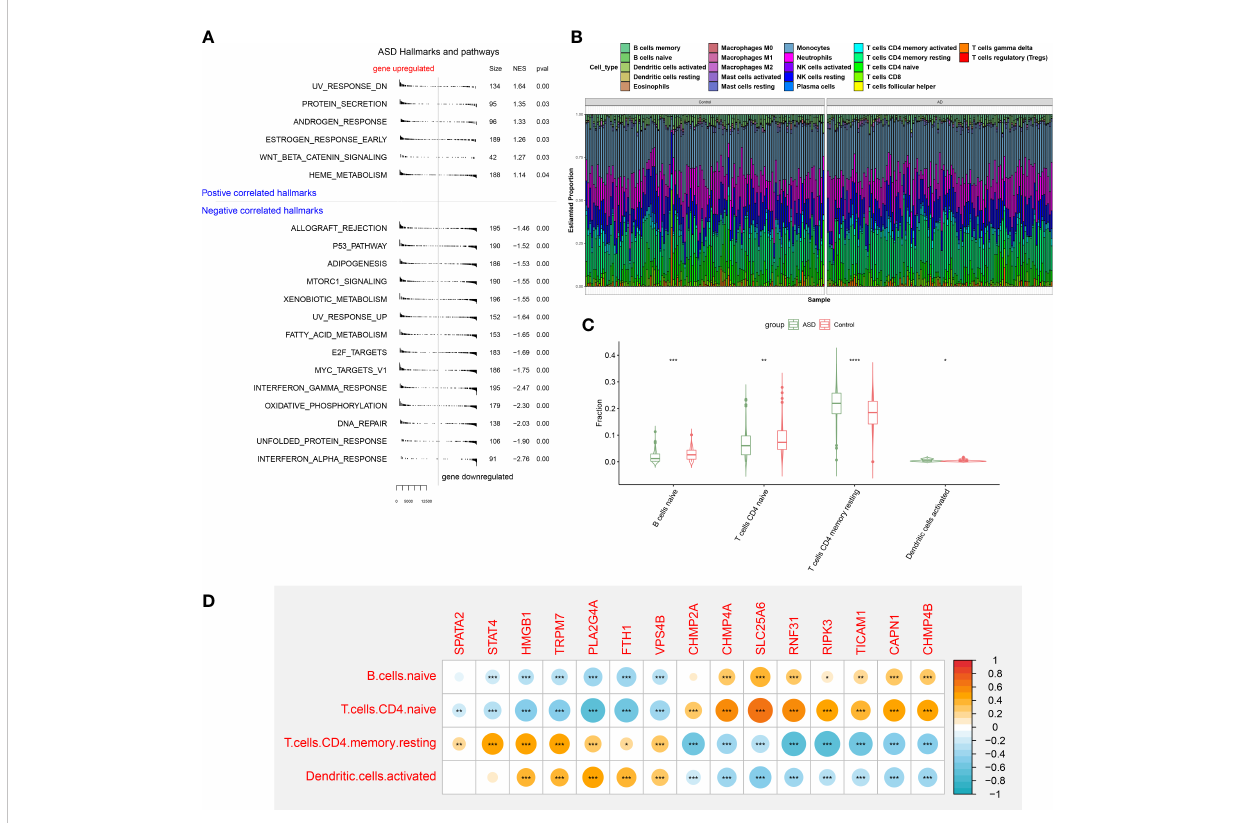
FIGURE 5 GSEA and immune in fi ltration analysis between healthy controls and ASD children. (A) GSEA showing up- or down-regulated KEGG pathways between healthy individuals and ASD children. A p-value less than 0.05 was considered to be statistically signi fi cant. (B) Representative stack chart revealing the relative abundances of 22 in fi ltrated immune cells between healthy individuals and ASD children. (C) Representative box plots revealing the in fi ltration levels of immune cells between healthy individuals and ASD children. (D) Representative correlation plot between 15 differentially expressed NRGs and in fi ltrated immune cells. * p < 0.05, ** p < 0.01, *** p <